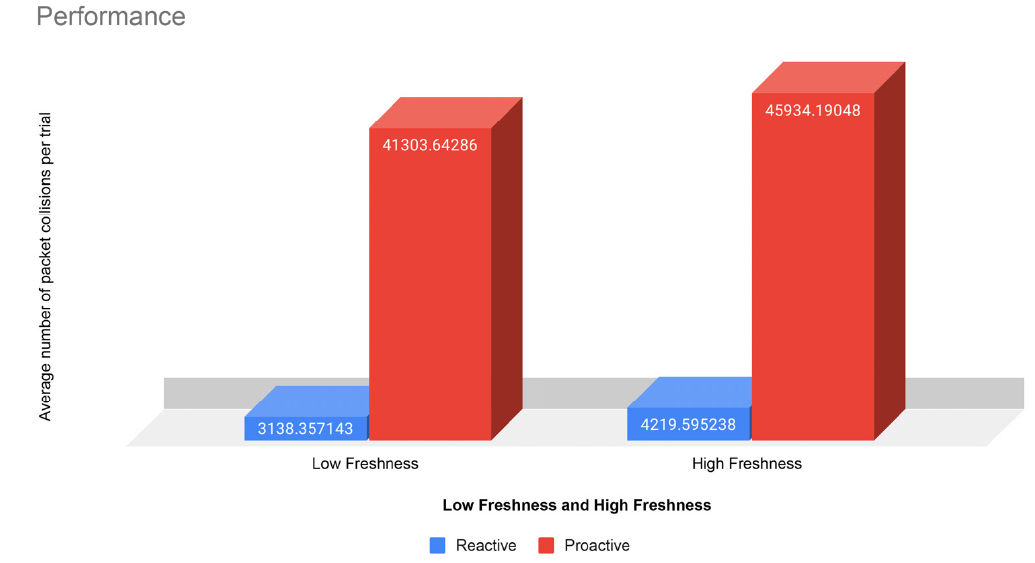
Figure 7. Comparison between the percentage of collisions from results of low freshness and high freshness.